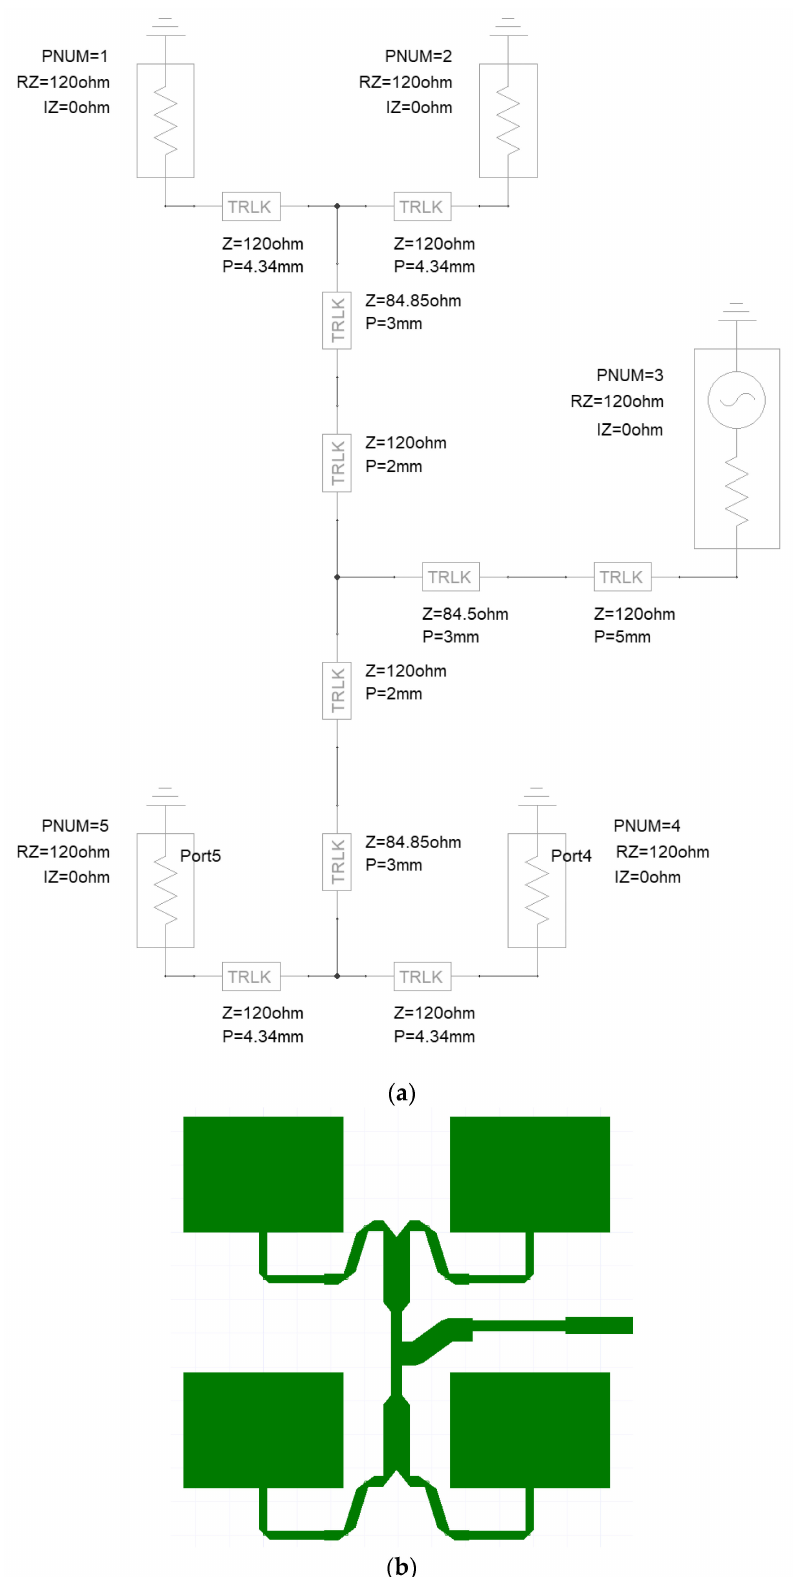
Figure 10. ( a ) Power division network for a 1 to 4 power ratio, with ideal transmission lines. ( b ) Power division network for a 1 to 4 power ratio. Microstrip radiators with microstrip transmission line